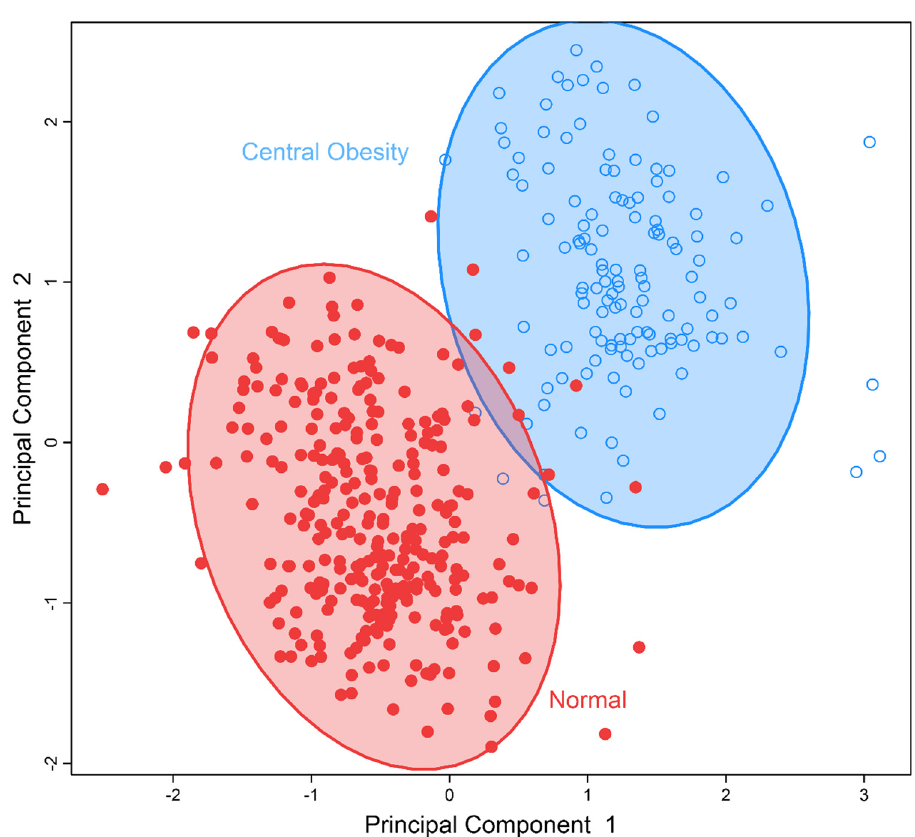
Fig 2. Separation of individuals with normal body weight versus those with abdominal obesity by a multi-metabolites score comprising of all metabolites significantly associated with waist circumference using sparse partial least-squares discriminant